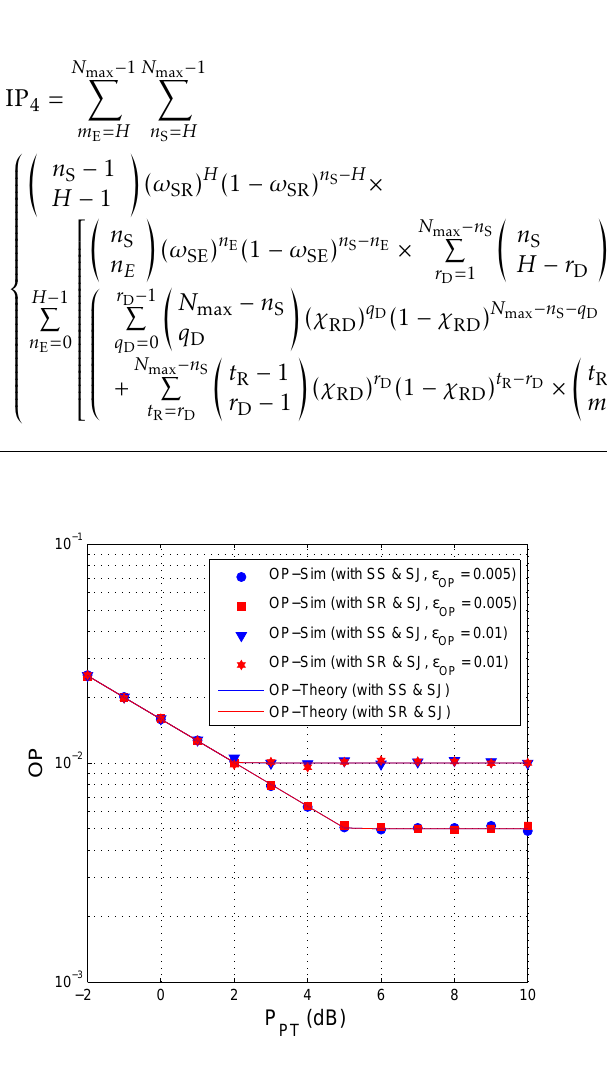
in (dB) with ε , PT OP = 0 . 005